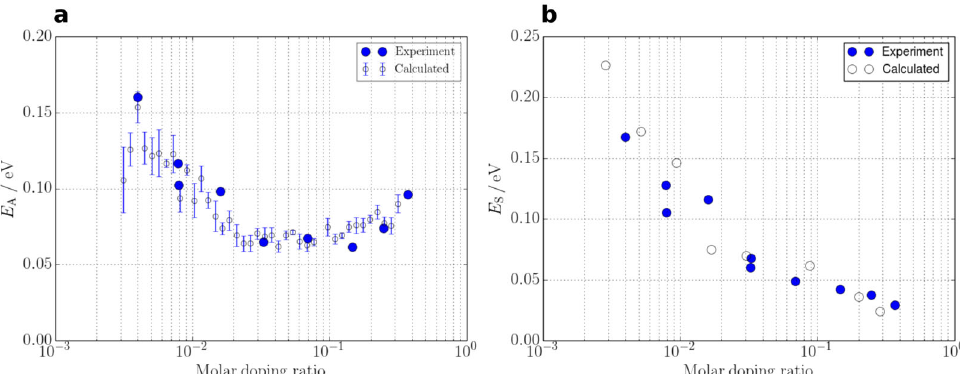
Fig. 6 Comparison of the activation energy of conductivity and the Seebeck energy. a Experimental and calculated activation energy of conductivity of C 60 :W 2 (hpp) 4 as a function of molar doping ratio. We used an amorphous structure of C 60 for the whole range of doping ratios (see Supplementary Table 3 for other parameter values). The excellent agreement of our results with the experimental data shows that the assumption of structural changes upon doping of C 60 is not necessary to explain the increase of activation energy at high concentrations, but it can be rationalized solely as the result of electrostatic fl uctuations. b Seebeck energy E S of C 60 :W 2 (hpp) 4 as a function of molar doping ratio. That E S , surprisingly, does not show an increase at high doping concentrations can now be understood: Although the critical hopping energy shows a stronger temperature activation, E S is determined by the average energy of the critical subnetwork with respect to the Fermi level. This average keeps decreasing as the Fermi level moves up in the DOS (see Supplementary Fig. 1 for the DOS plots). Error bars show one standard deviation. Experimental data reproduced from ref. 56 , Figs. 3 and